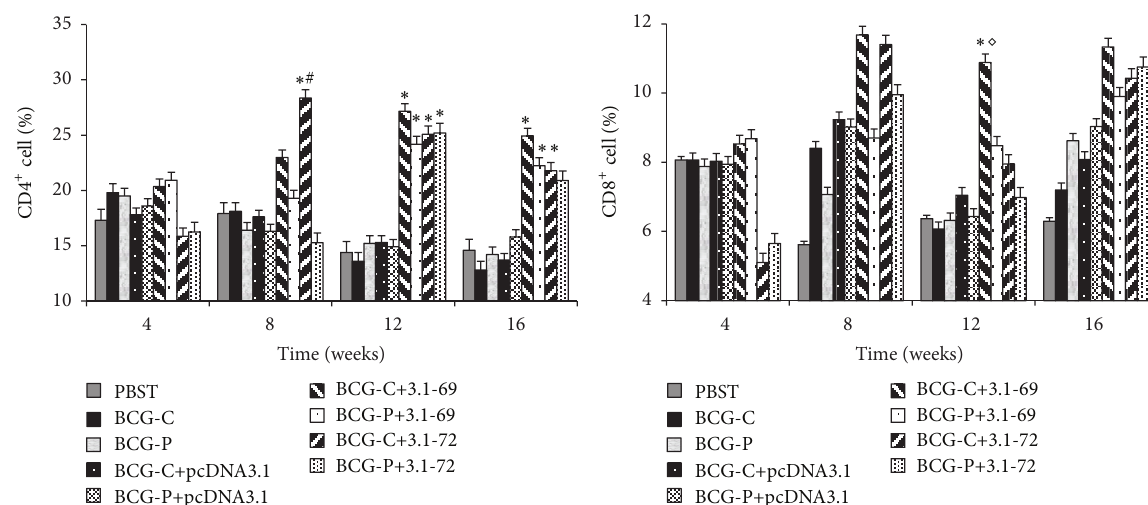
Figure 3: Analysis of the percentages of CD4 + and CD8 + cells (%). Animals were immunized and killed; the splenocytes were collected and handled as described in Section 2. Flow cytometry was used to determine the proportions of splenocyte subsets, and the results are presented as mean ± standard errors. ∗ 𝑃 < 0.01 versus PBST, BCG-C, BCG-P, BCG-C +pcDNA3.1, or BCG-P+pcDNA3.1 groups. # 𝑃 < 0.05 versus BCG-P+3.1-69 or BCG-P+ 3.1-72 group. ◊ 𝑃 < 0.05 versus BCG-P+3.1-69, BCG-C+3.1-72, or BCG-P+3.1-72 groups.